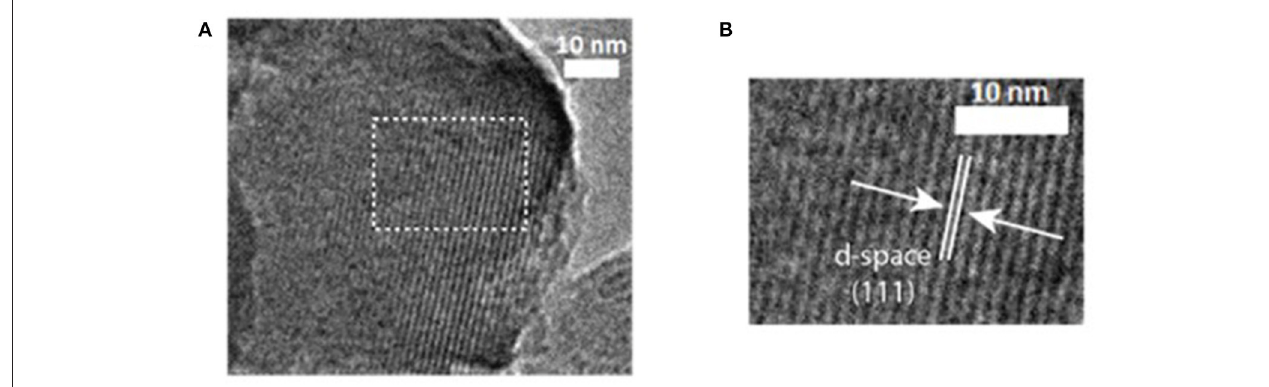
FIGURE 4 | (A) TEM images of ZTC40 showing the periodicity of the ordered carbon and (B) magnification of the dashed white box.